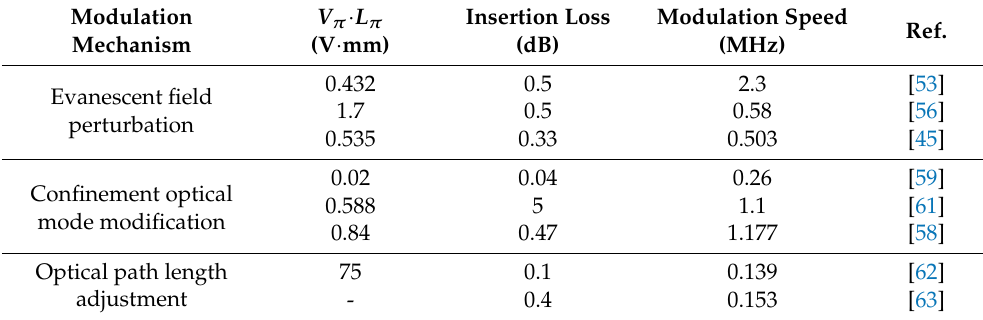
Figure 5. MEMS phase shifter through modulating optical path length utilizing ( a ) deformable silicon strip waveguide, ( b ) a pair of horizontal directional couplers. Table 1. Performance summary of MEMS-based phase